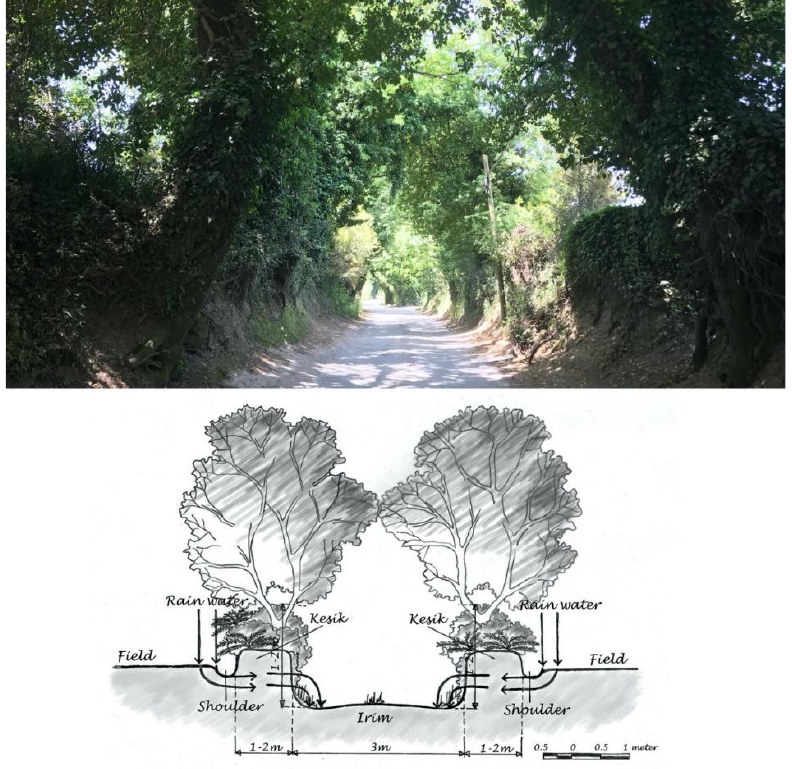
Figure 3 Section of irim and